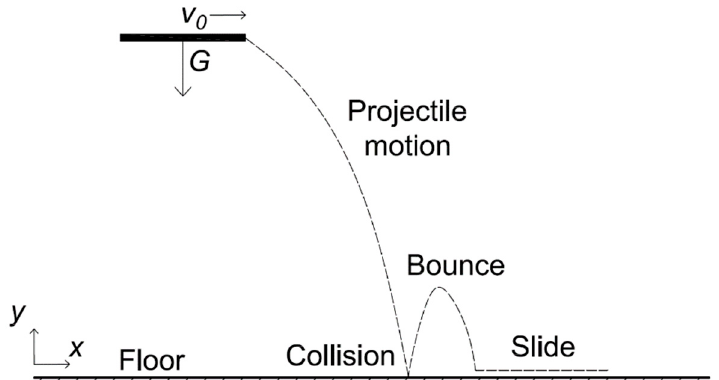
Figure 3. Falling process for a ceiling tile in the physical model.